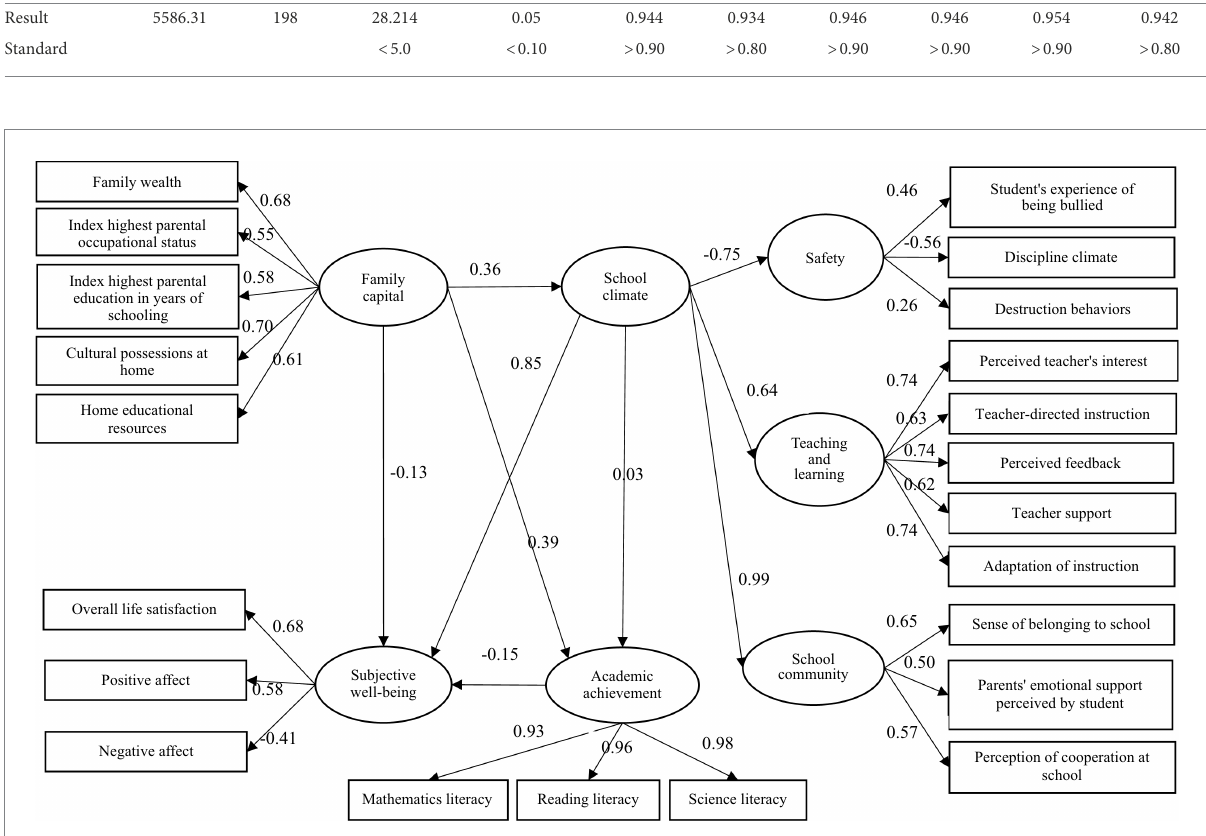
FIGURE 3 The path model of family capital influencing adolescents’ subjective well-being.